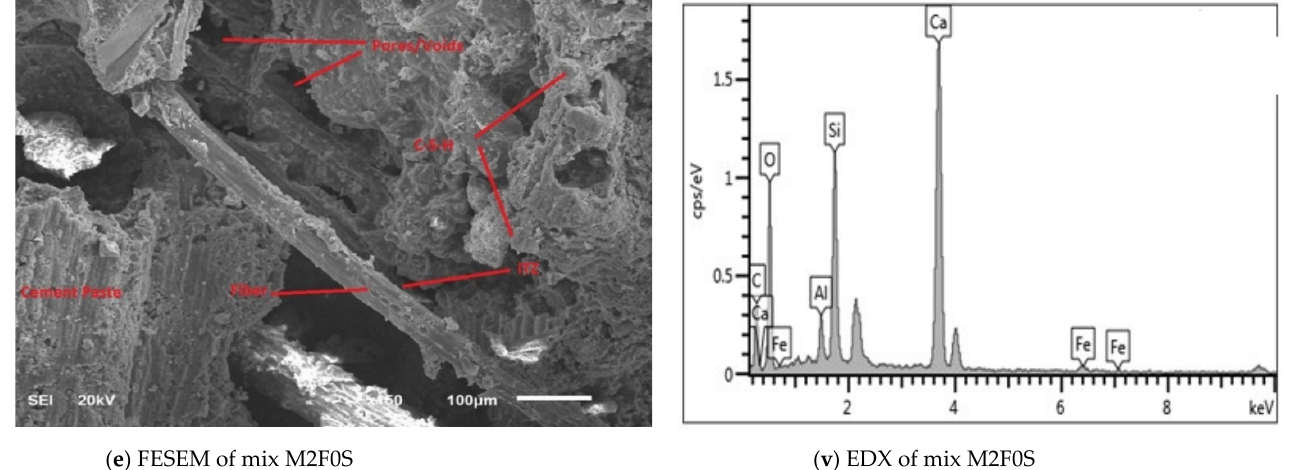
Figure 12. Microstructural morphology of DPF-reinforced concrete. Table 4. Elemental compositions obtained from EDX analysis.